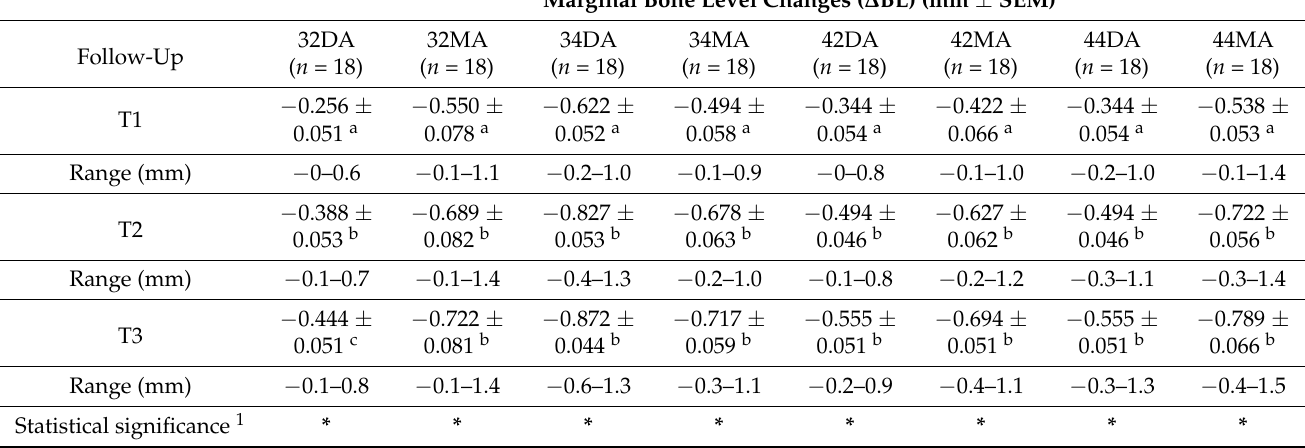
Table 5. Marginal bone level changes around individual implants in the mandible during the 42-month study